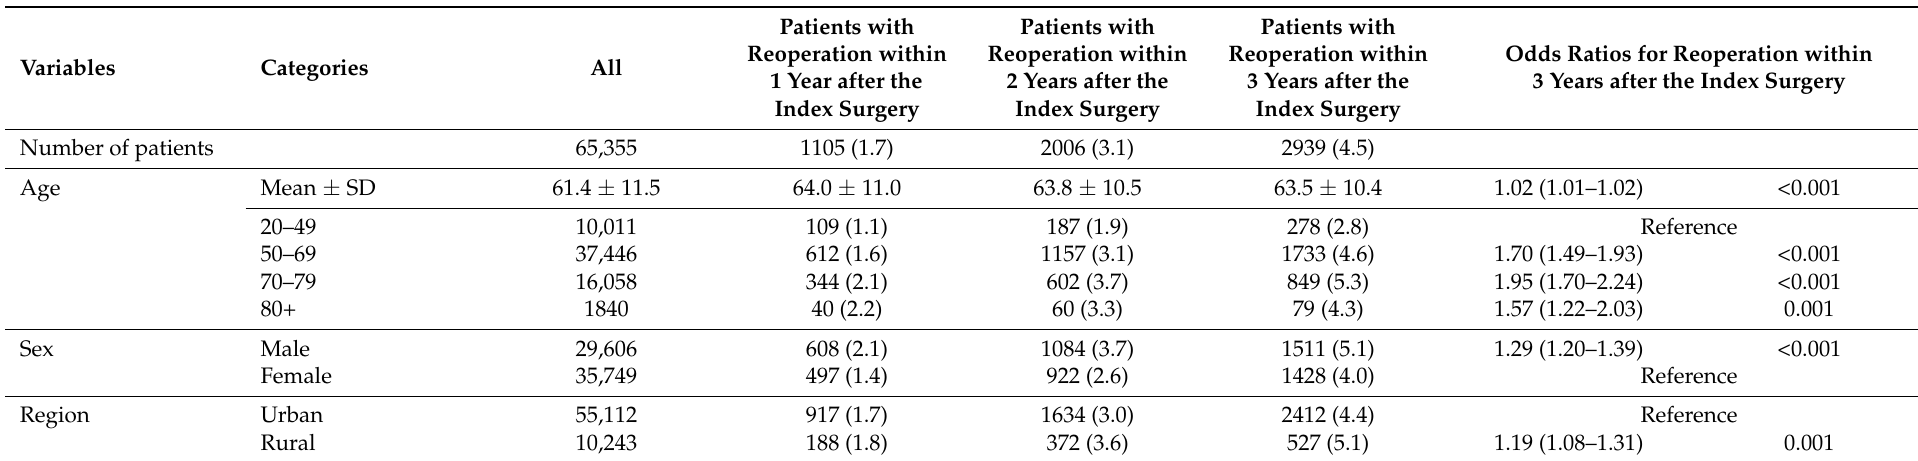
Table 2. Annual reoperation rates according to patients’